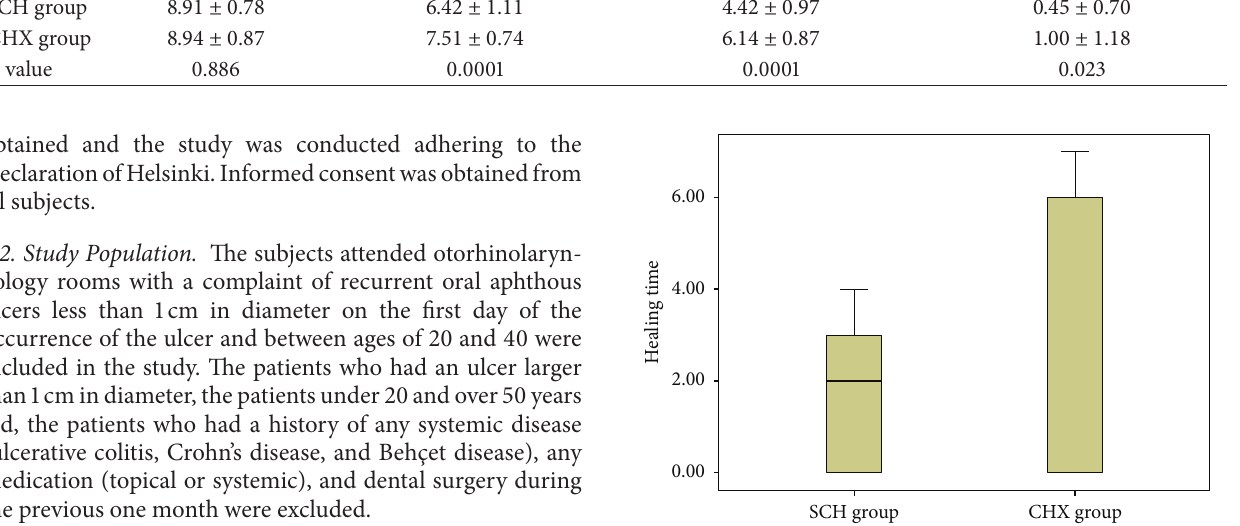
Table 1: The mean value of pain scores at admission and on the days after the treatment. Before the treatment